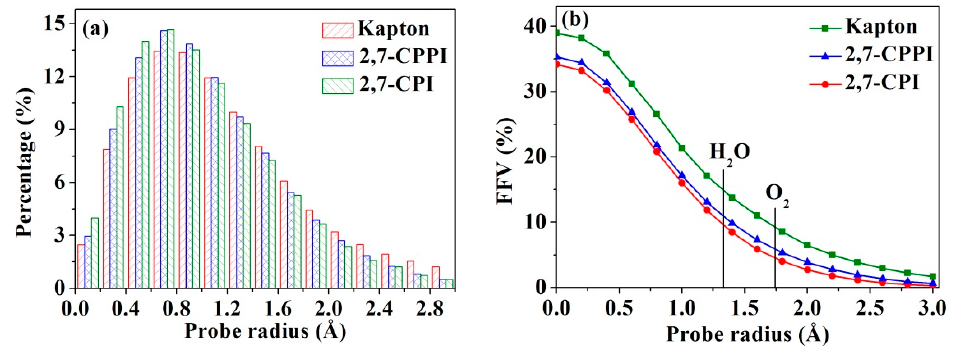
Figure 8. Distributions of void radius ( a ) and fractional free volume ( b ) as a function of probe radius in Kapton, 2,7-CPPI and 2,7-CPI. The kinetic radii of O 2 and H 2 O are indicated by vertical lines.